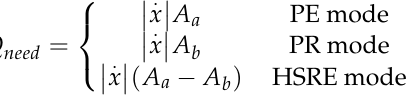
Table 3. Rule table of FLC for pump.